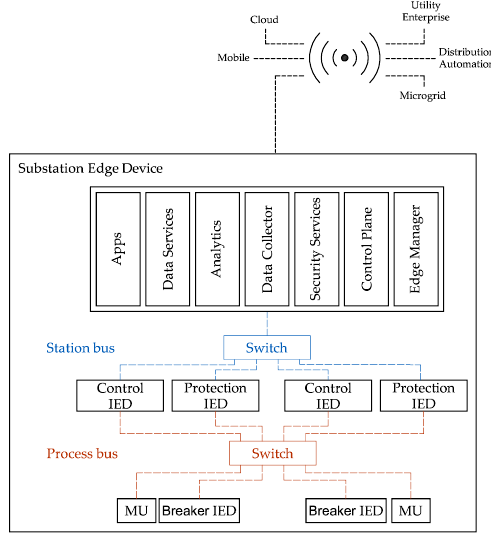
Figure 7. Digitally enabled substation.